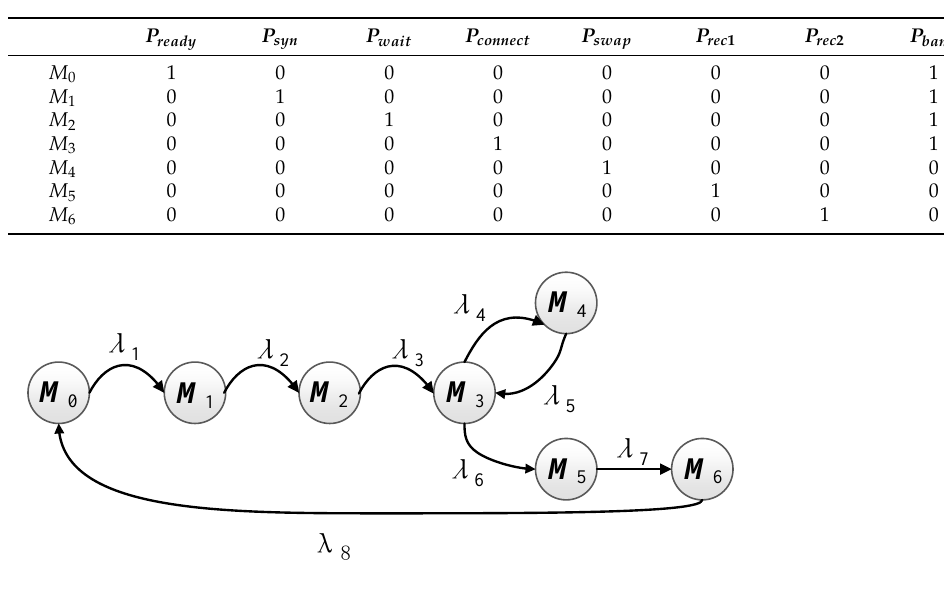
Table 5. Reachable marking set of the SPN model.